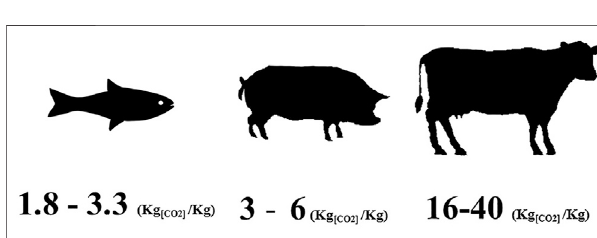
FIGURE 2 | Fish carbon dioxide production (kg produced per kg of biomass) compared with terrestrial animals reared for protein and lipid